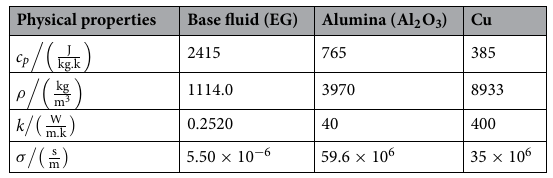
Table 1. Thermophysical characteristics of nanoparticles and base fluid 76